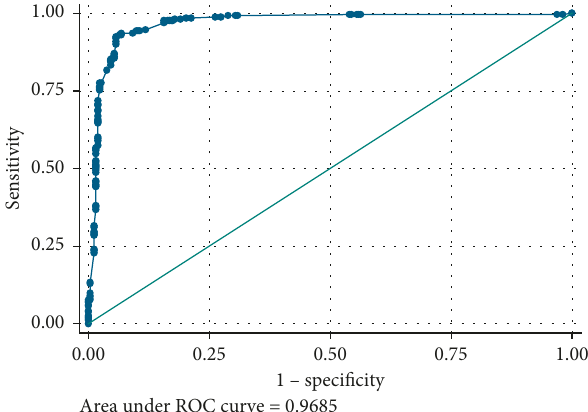
Figure 1: ROC curve showing the performance of SAM predictive score.